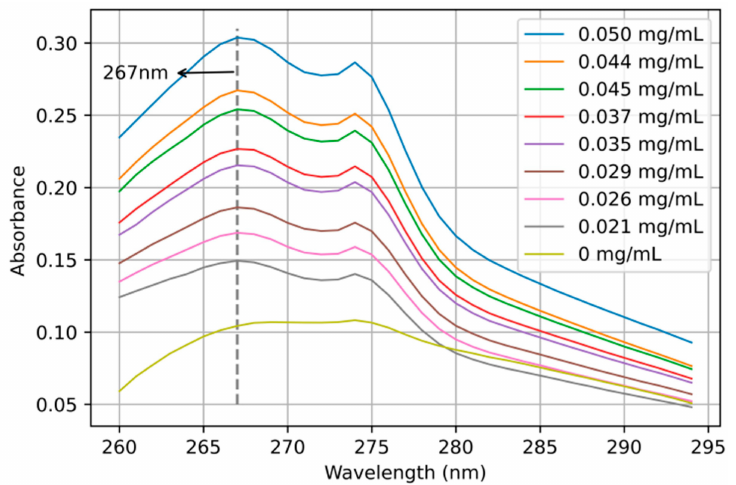
Figure 4. Absorption spectra of dihydrocoumarin in coconut juice at different concentrations.